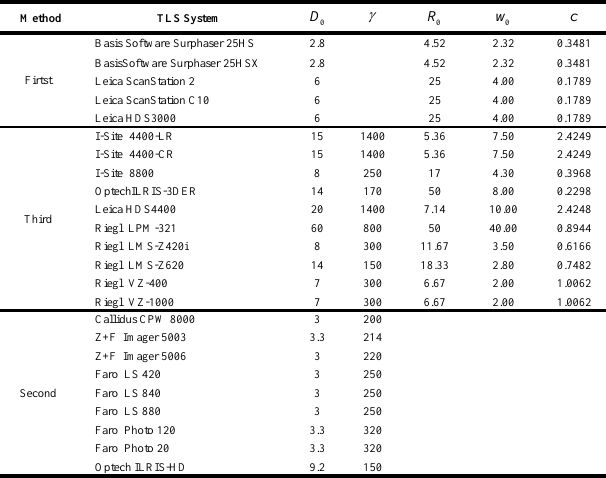
Table 1. The coefficient of the formulas of different scanner ’ s beamwidth diameter Method